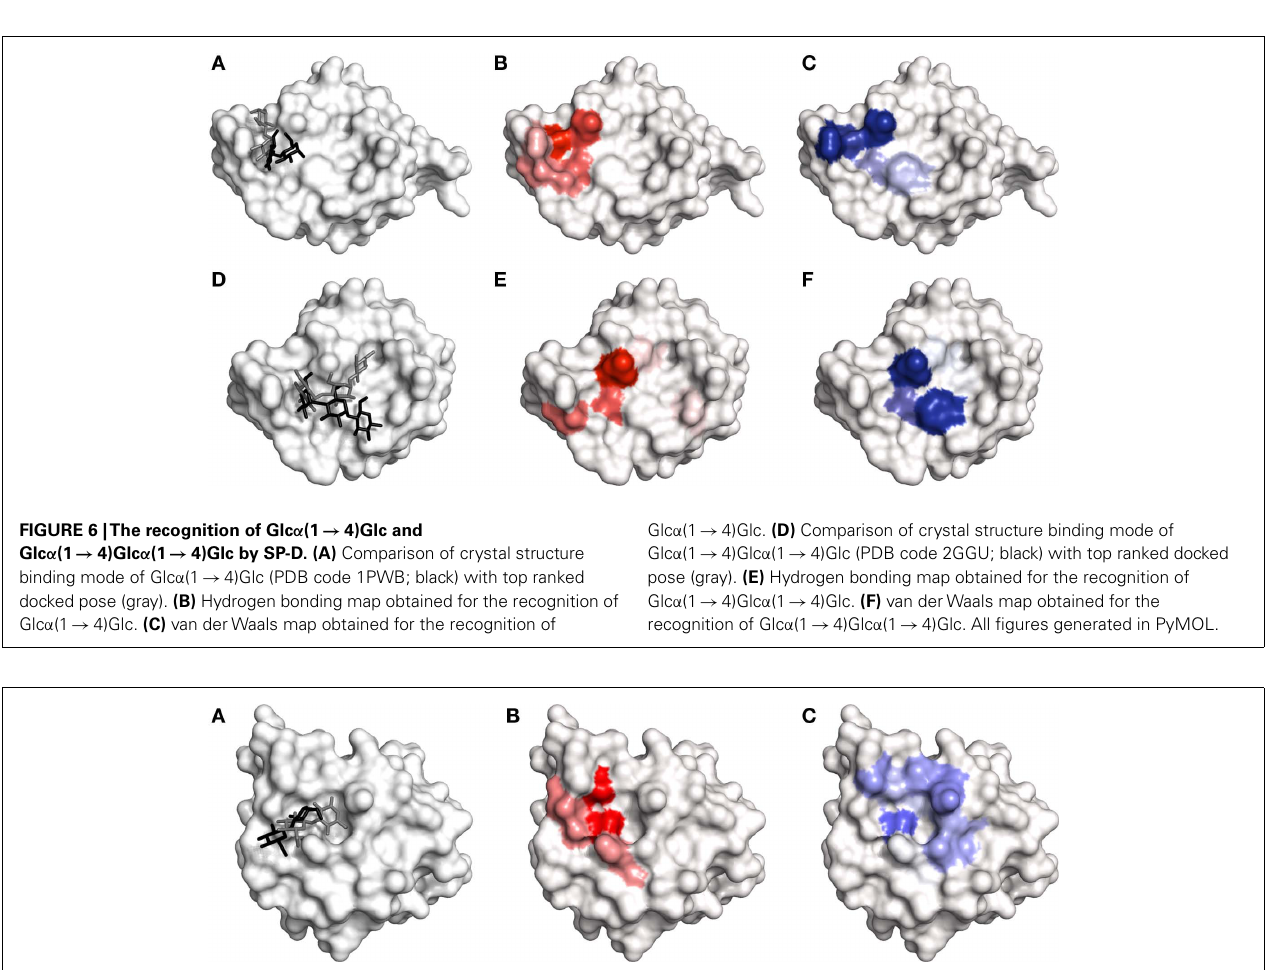
with top ranked docked pose (gray). (B) Hydrogen bonding map. (C) van der Waals map. All figures generated in PyMOL.